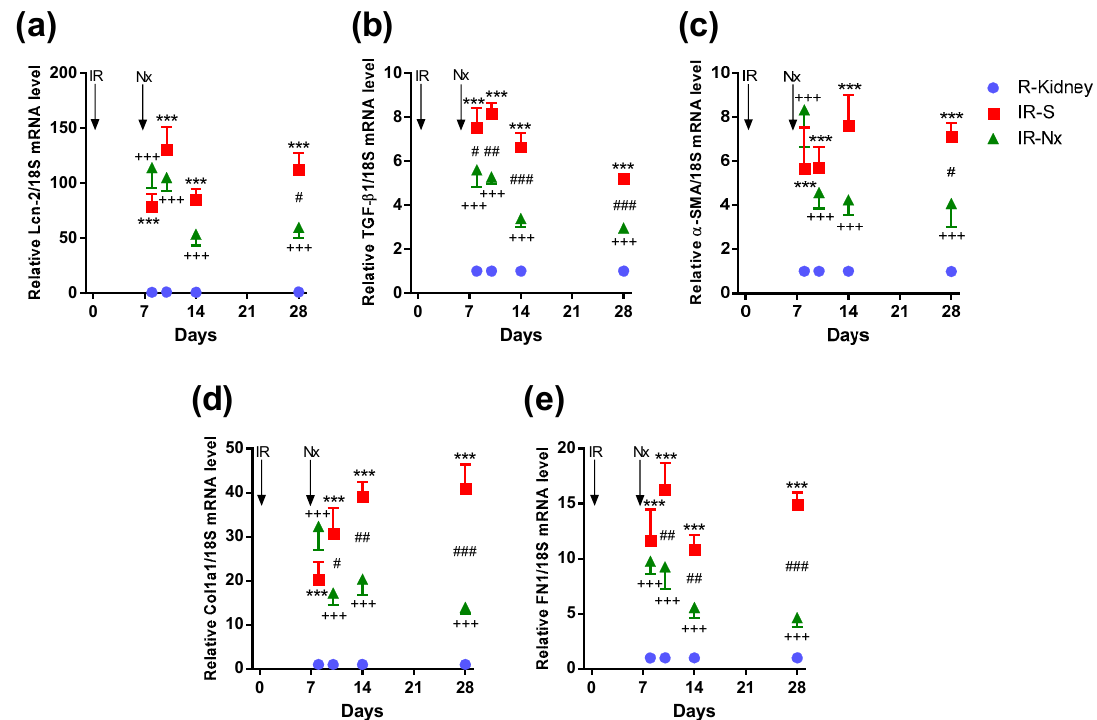
Figure 8. Fold changes in lipocalin-2 (Lcn-2) and fibrotic mRNAs normalized to 18S. ( a ) Lcn-2, ( b ) transforming growth factor-beta (TGF- β ), ( c ) alpha-smooth muscle actin ( α -SMA), ( d ) collagen-1a1 (Col1a1) and ( e ) fibronectin-1 (FN1). Data are expressed as mean ± SEM and two-way ANOVA with Tukey’s post hoc test. ***: p < 0.001 IR-S (red) vs. nonischemic right kidneys (blue); +++ : p < 0.001 IR-Nx (green) vs. nonischemic right kidneys (blue), #: p < 0.05, ##: p < 0.01 and ###: p < 0.001 IR-S (red) vs. IR-Nx (green).